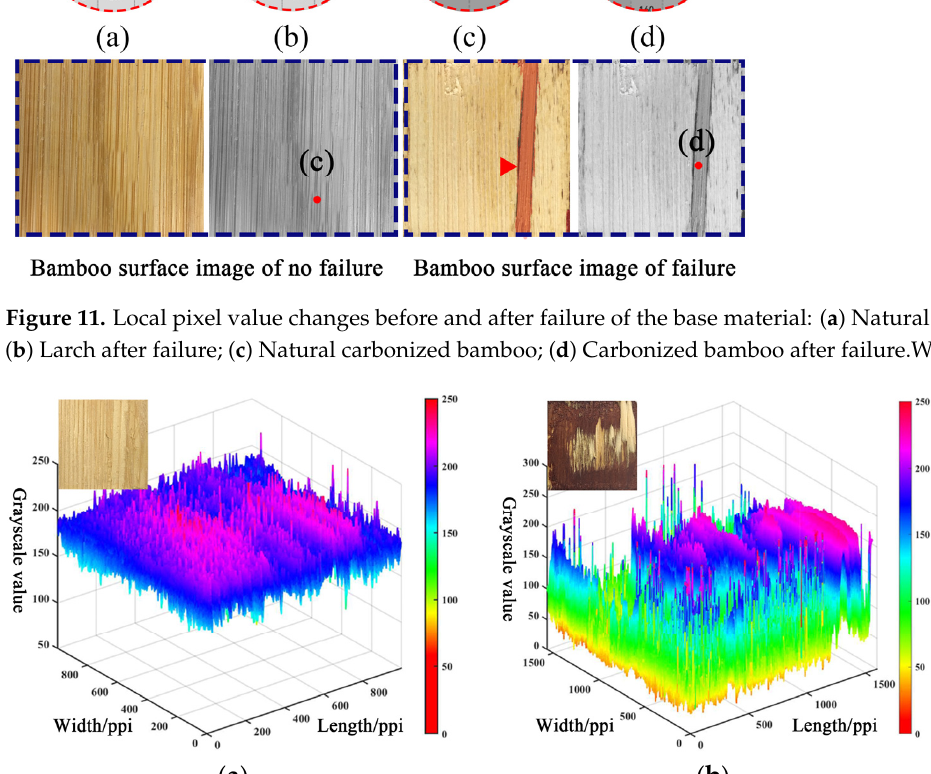
Figure 12. Effect of adhesive type change on grayscale value: ( a ) Effect of PF adhesives on grayscale values; ( b ) Effect of PF adhesives on grayscale values.